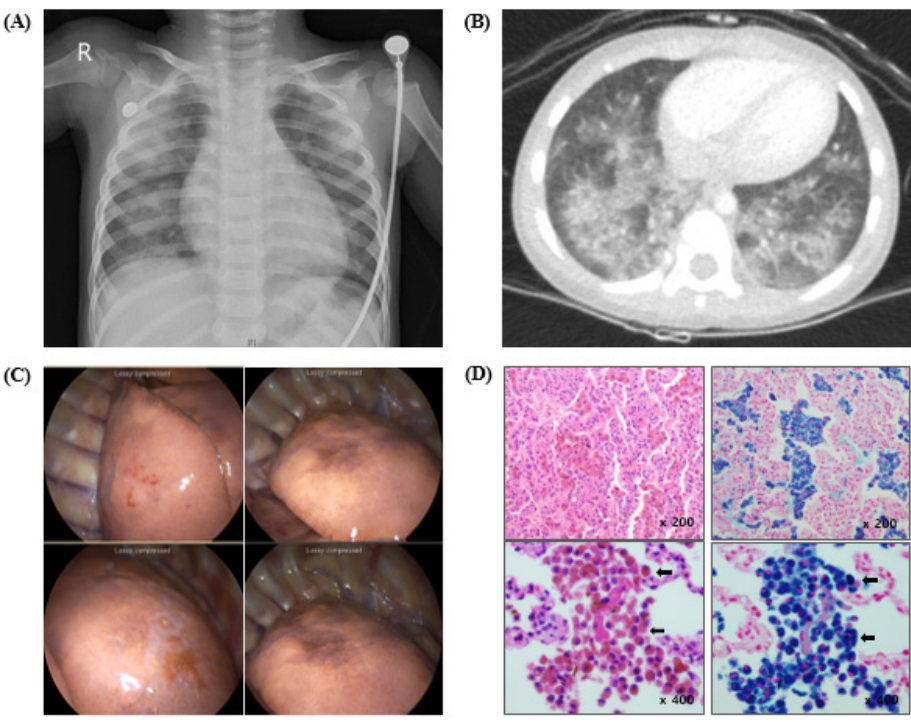
Figure 1. Radiographic and pathologic findings of Case 1 with IPH. ( A ) Initial chest radiograph showing bilateral pulmonary infiltrates. ( B ) Chest computed tomography (CT) revealing diffuse bilateral symmetric alveolar infiltrates. ( C ) Lungs showing brownish discoloration. ( D ) H & E stain (left) and Prussian blue stain (right) (×200, ×400) showing hemosiderin-laden macrophages in alveolar spaces (black arrows).